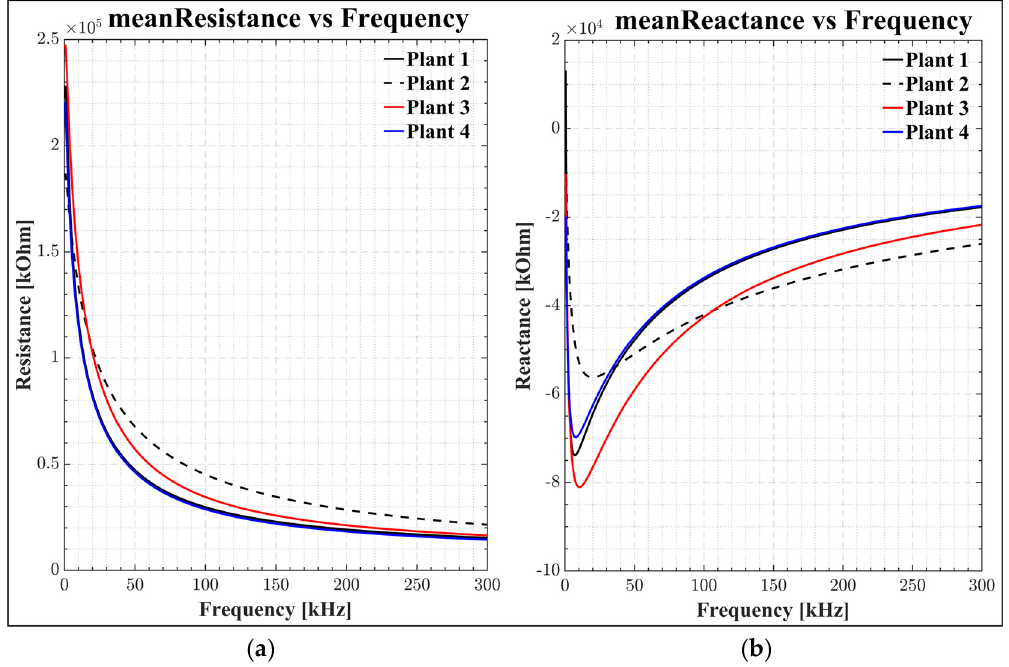
Figure 7. ( a ) Frequency-dependent resistance; ( b ) frequency-dependent reactance graphs, where ( f ) is the measured resistance, and mean ℵ ( f ) is the measured reactance for various mean R p , T i plants (plants 1 to 4) with an average try as a function of frequency.